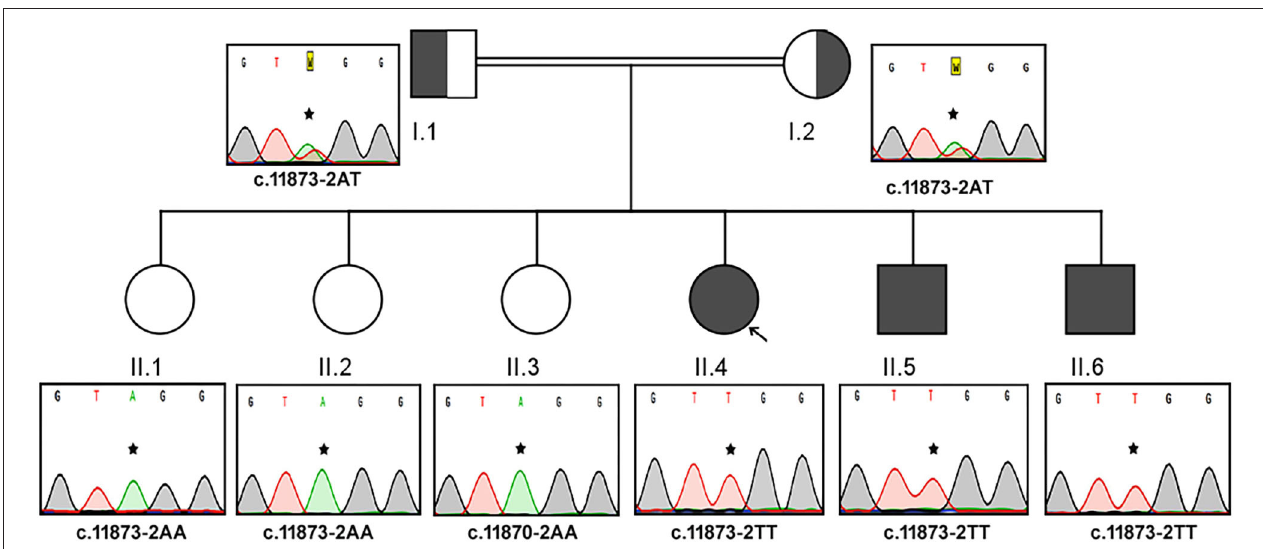
FIGURE 2 | Pedigree and the DNA sequence analysis of AS Family B. Each DNA chromatogram (reverse strand) shows the result from the Sanger sequencing confirming the status of the mutation. Both parents (I.1 and I.2) are heterozygotes, three AS patients are homozygous for TT, while the three unaffected siblings are homozygotes for AA genotype for the given genetic